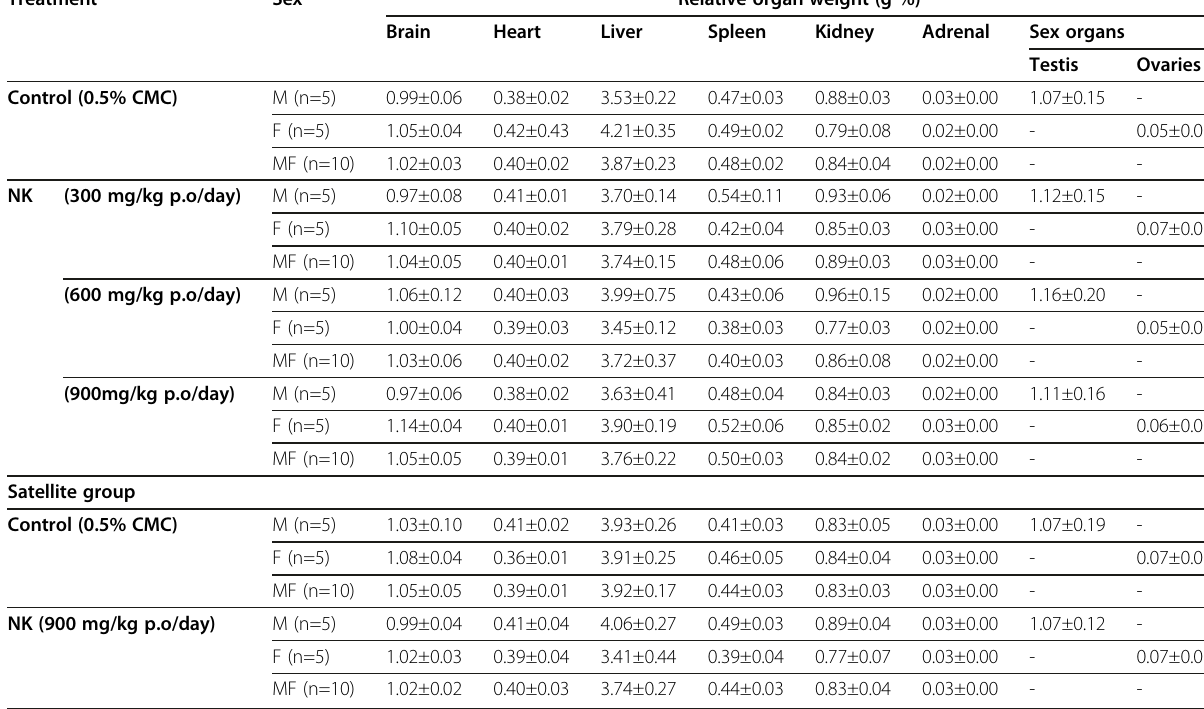
Table 11 Effect of Nuna kadugu on relative organ weight of experimental Sprague Dawley rats in repeated oral toxicity study